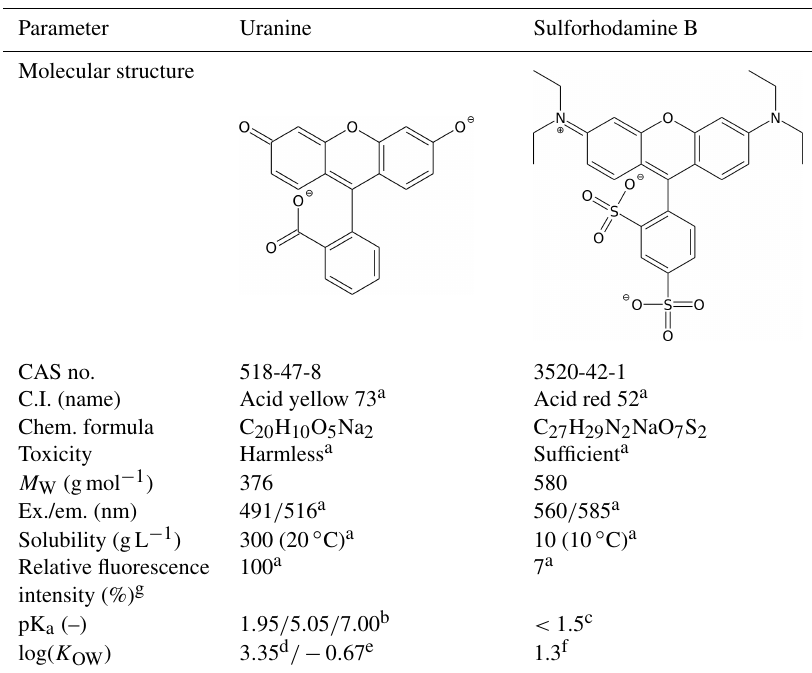
Table 3. Characterisation of fluorescent